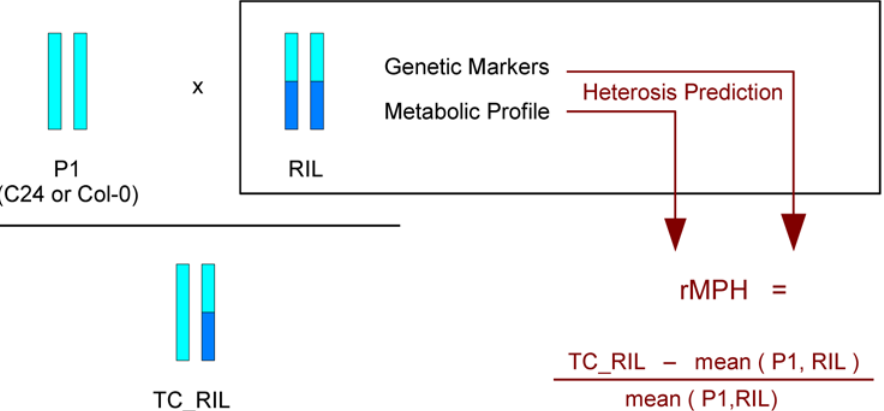
Figure 1. Rationale of the experimental outline. The experimental set-up comprised the two Arabidopsis thaliana accessions C24 and Col-0, which served one at a time as the first parent of the testcrosses. One of 359 recombinant inbred lines derived from the two original accessions acted as the second parent. The analysis implicated the metabolic profile and genetic markers of the RILs, which were then used to predict the relative mid- parent heterosis rMPH in biomass. The latter is defined as the relative biomass gain of the testcross as compared to the mean biomass of its parents (cf. Methods section for details) and therefore manifests itself not until the next generation. P1 describes the shoot biomass of the first parent, RIL the shoot biomass of the particular recombinant inbred line and TC_RIL the shoot biomass of the corresponding testcross. The function mean( N , N ) refers to the arithmetic mean of the respective values.